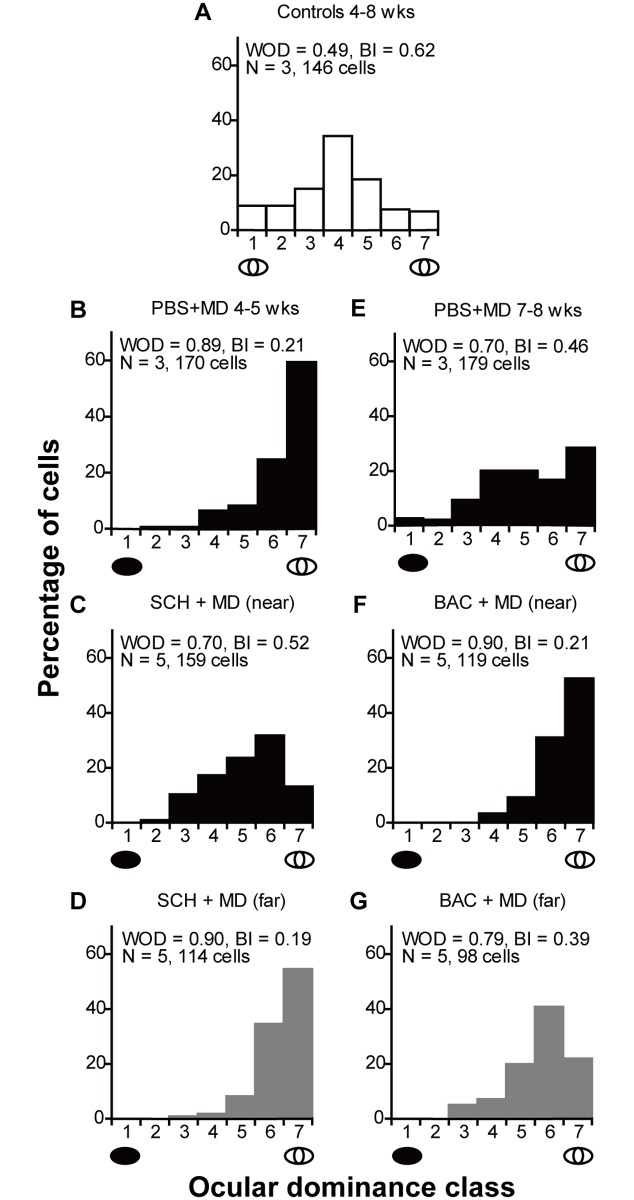
GABAB receptor bidirectionally regulates OD plasticity during the critical period.(A) OD distribution for 4-8-week-old control kittens (N = 3). Note that the majority of cells receive input from both eyes. (B-D) OD distributions for 4-5-week-old kittens subject to 4 days of MD and infused with PBS, or the GABAB receptor antagonist SCH50911 (SCH). Note that MD resulted in an OD shift toward the open eye (B) (p = 0, χ2 test), which was reduced near (C) but not far (D) from the SCH50911 infusion site (p = 1.14 × 10−13, χ2 test). (E-G) OD distributions for 7–8 weeks old kittens subject to 4 days of MD and infused with PBS, or the GABAB receptor agonist baclofen (BAC). Note that MD at 7–8 weeks of age (E) induced a weaker OD shift than in younger animals (p = 1.56 × 10−11, χ2 test, cf. 1B and 1E). However, this OD shift was enhanced near (F) but not far (G) from the baclofen infusion site (p = 2.66 × 10−5, χ2 test). WOD = weighted ocular dominance. BI = binocularity index. N = number of animals.